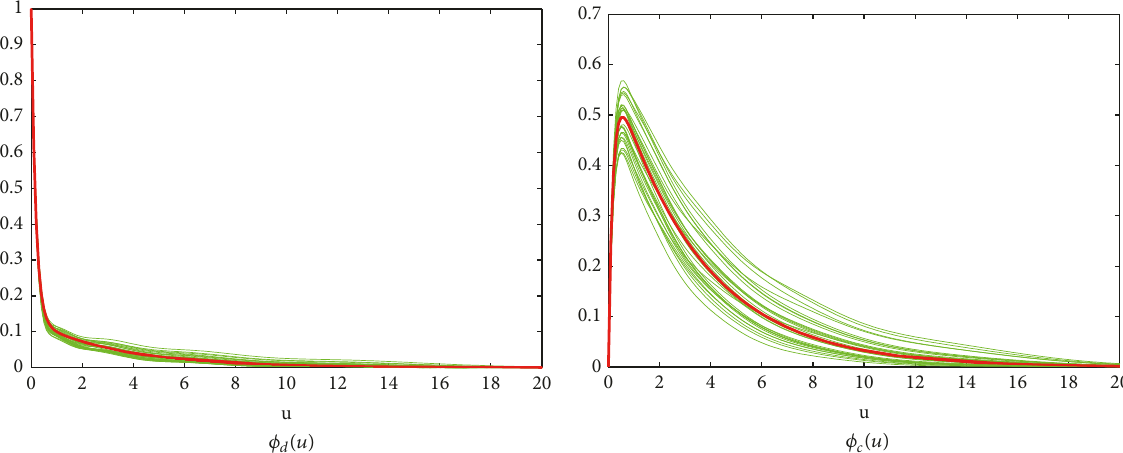
Figure 2: Estimating the Laplace transform of ruin time for exponential claim sizes, true curve (red curve) and 30 estimated curves (green curves).